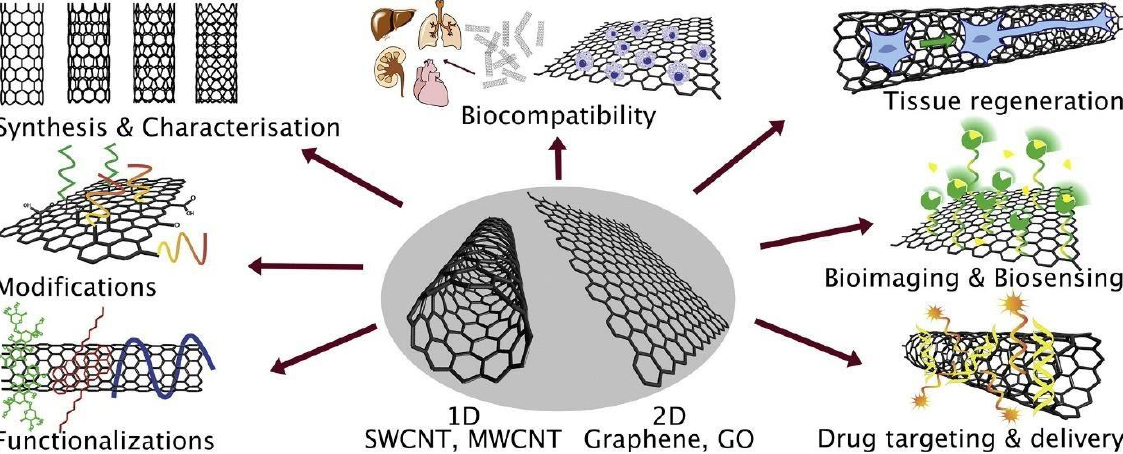
Figure 5. Schematic presentation showing carbon nanotubes alongside their precursor, graphene, and their uses in the biomedical field [63]. Copyright 2018, Elsevier.